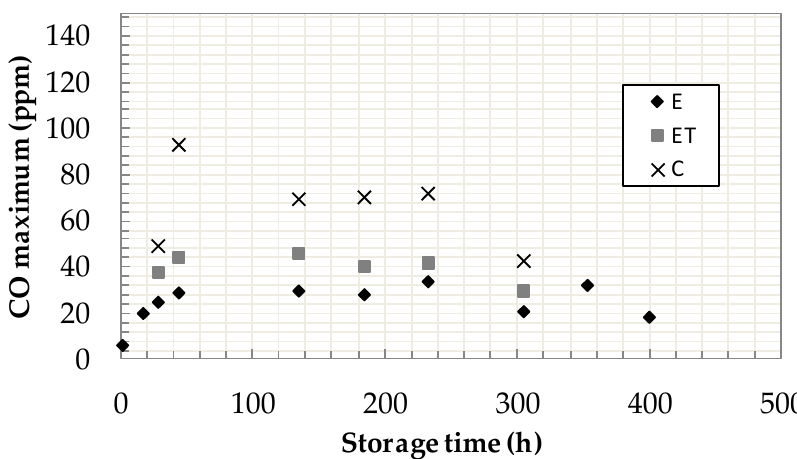
Figure 4. Maximum CO levels (ppm) vs. storage time (h) (experiment 1).